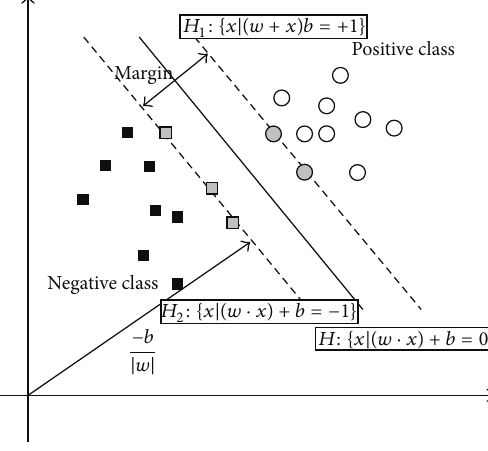
Figure 4: Classification of two classes of data using